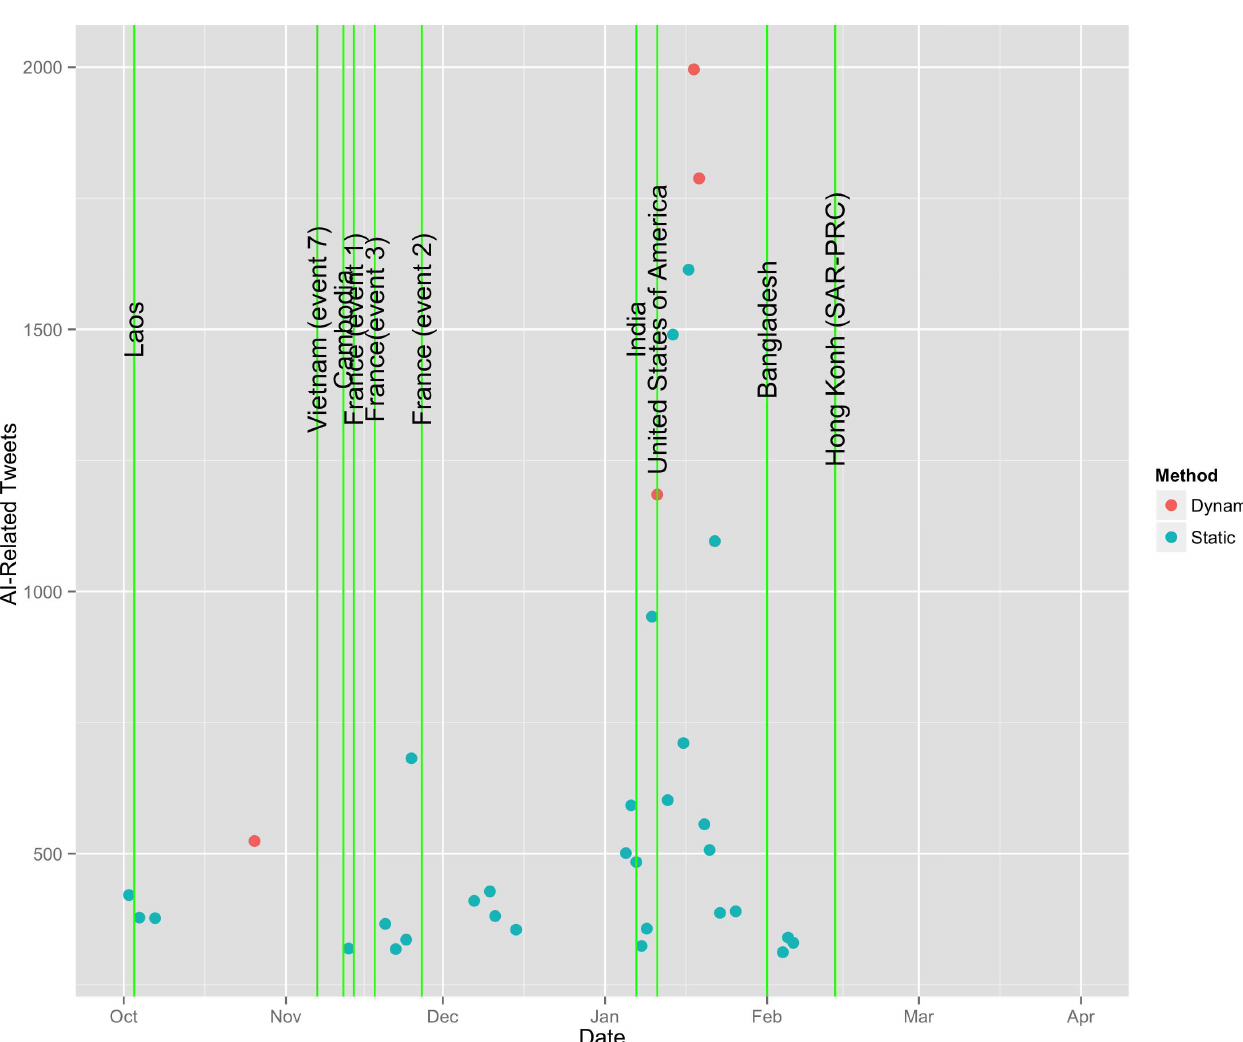
Fig 10. Official OIE outbreaks that started during the period of surveillance vs outbreaks identified on Twitter, green vertical lines indicate start dates obtained from OIE